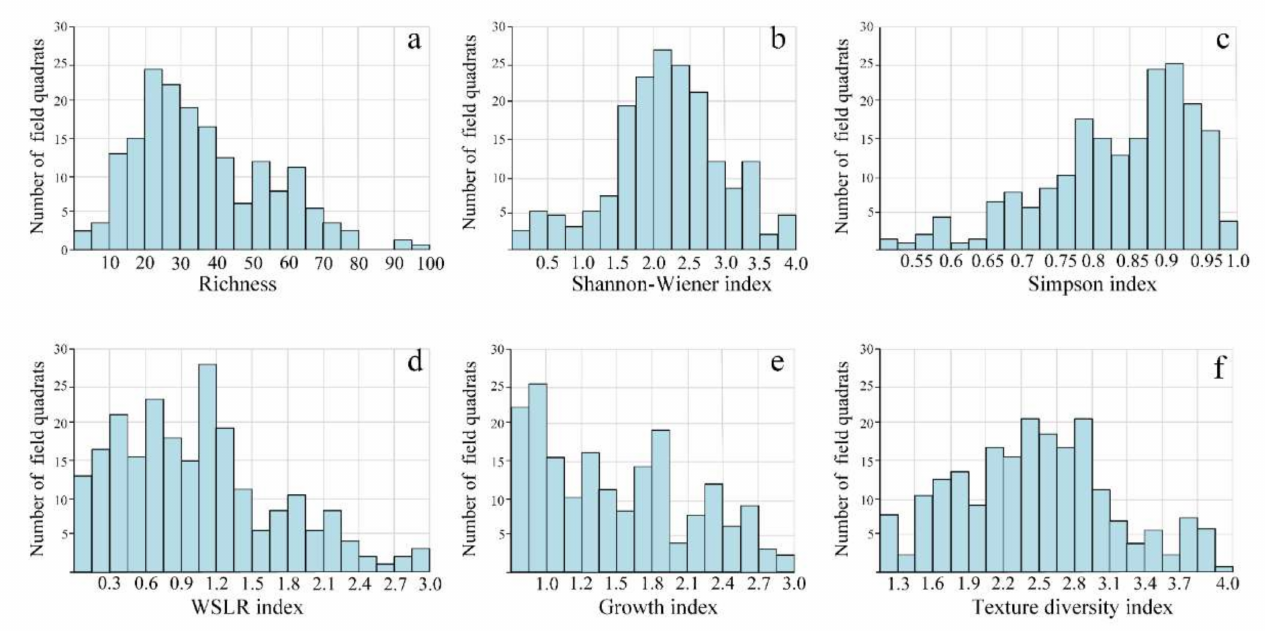
Figure 4. Histograms of six plant diversity indices captured from the field surveys. The X-coordinate is the diversity index values and the Y-coordinate is the frequency occurrence of field quadrat values. ( a ) Richness; ( b ) Shannon-Wiener; ( c ) Simpson; ( d ) WSLR, water and soil loss risk; ( e ) Growth index; and ( f ) Texture diversity